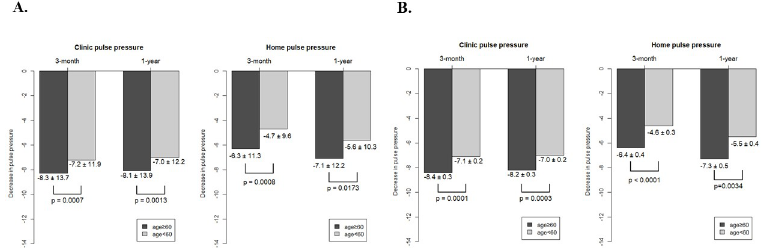
Fig 2. Bar graphs depicting comparison of pulse pressure reduction between elderly vs nonelderly patients. (A) Both clinic (left panel) and home (right panel) pulse pressure reductions were significantly greater in elderly patients at 3 months and 1 year following initiation of fimasartan therapy. (B) Even after adjusting for sex, body mass index, diabetes mellitus, alcohol and smoking, clinic (left panel) and home (right panel) pulse pressure decreased significantly greater in elderly patients for 3 months and 1 year follow-up. � Adjust for sex, body mass index, diabetes mellitus, alcohol and smoking.